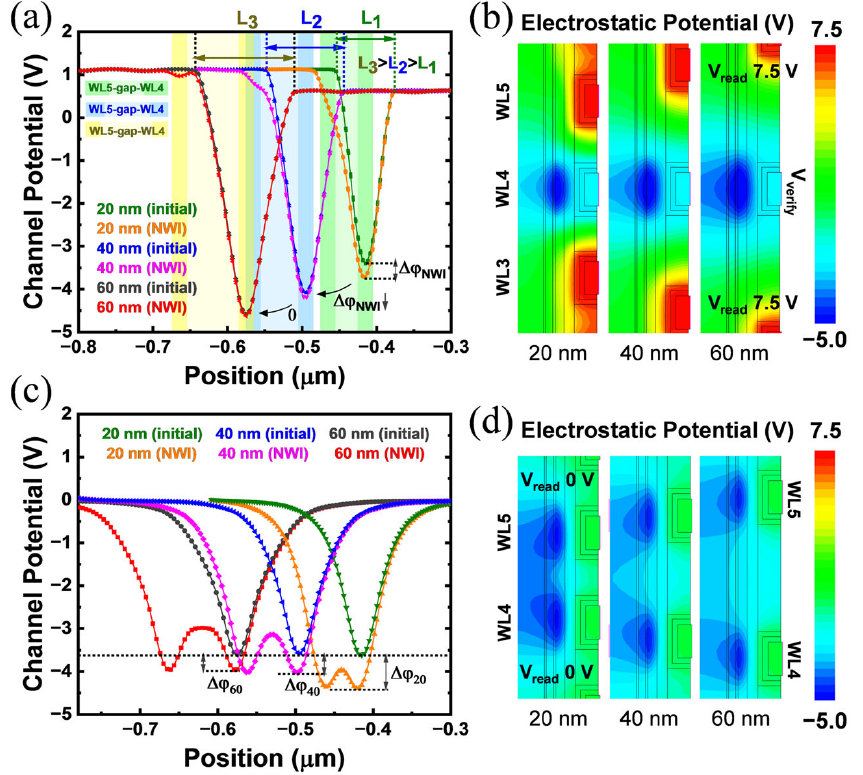
Figure 6. Channel potential distribution of the 3D NAND string with 20 nm, 40 nm and 60 nm WL gaps (isolations). ( a ) Simulation with read bias applied on boundary. ( c ) Simulation without any boundary bias. Both of the right patterns ( b , d ) visually show the electrostatic potential distribution around the victim WL, corresponding to the left.